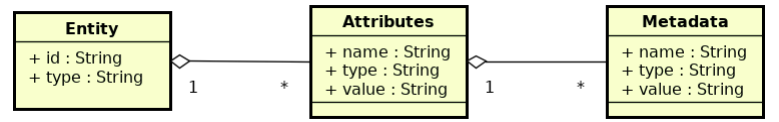
Figure 2. Next Generation Service Interfaces (NGSI) entity model.